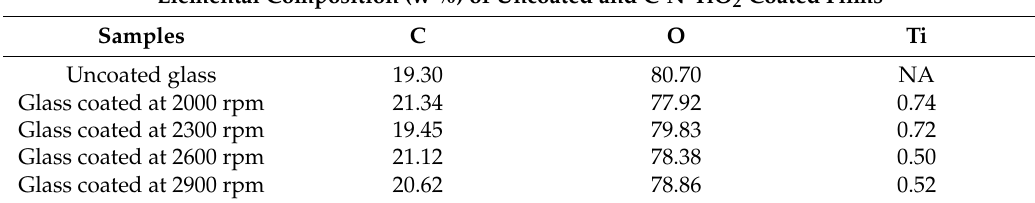
Table 3. Normalised weight percentages of elements C, Ti, and O in the films coated at di ff erent speeds and constant sol gel-solvent volume ratio (3:5) and coating time of 90 s, followed by annealing at 350 ◦ C, at a ramping rate of 10 ◦ C / min for 105 min.